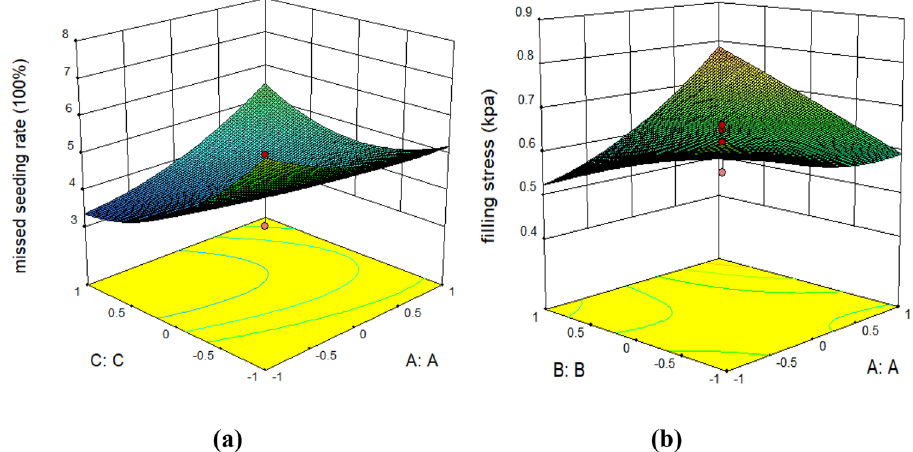
Figure 13. Effect of interaction between factors on missed seeding rate and coefficient of filling stress. ( a ) Missed seeding rate; ( b ) seed-filling